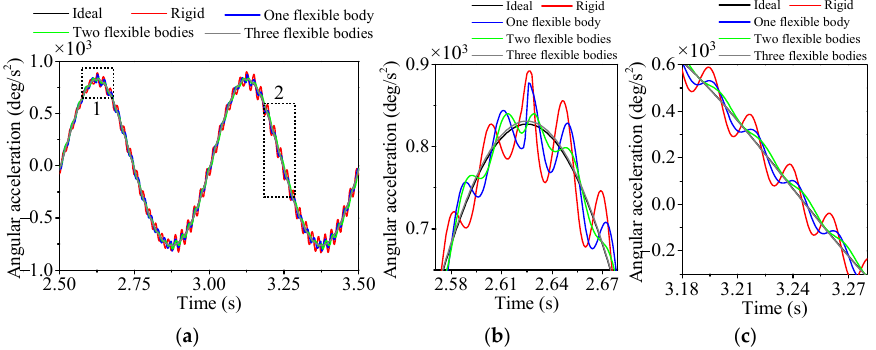
Figure 17. Angular acceleration of the rigid-flexible flap actuation system with different flexible body number when considering a single clearance joint: ( a ) angular acceleration; ( b , c ) partial enlarged drawings 1,2.